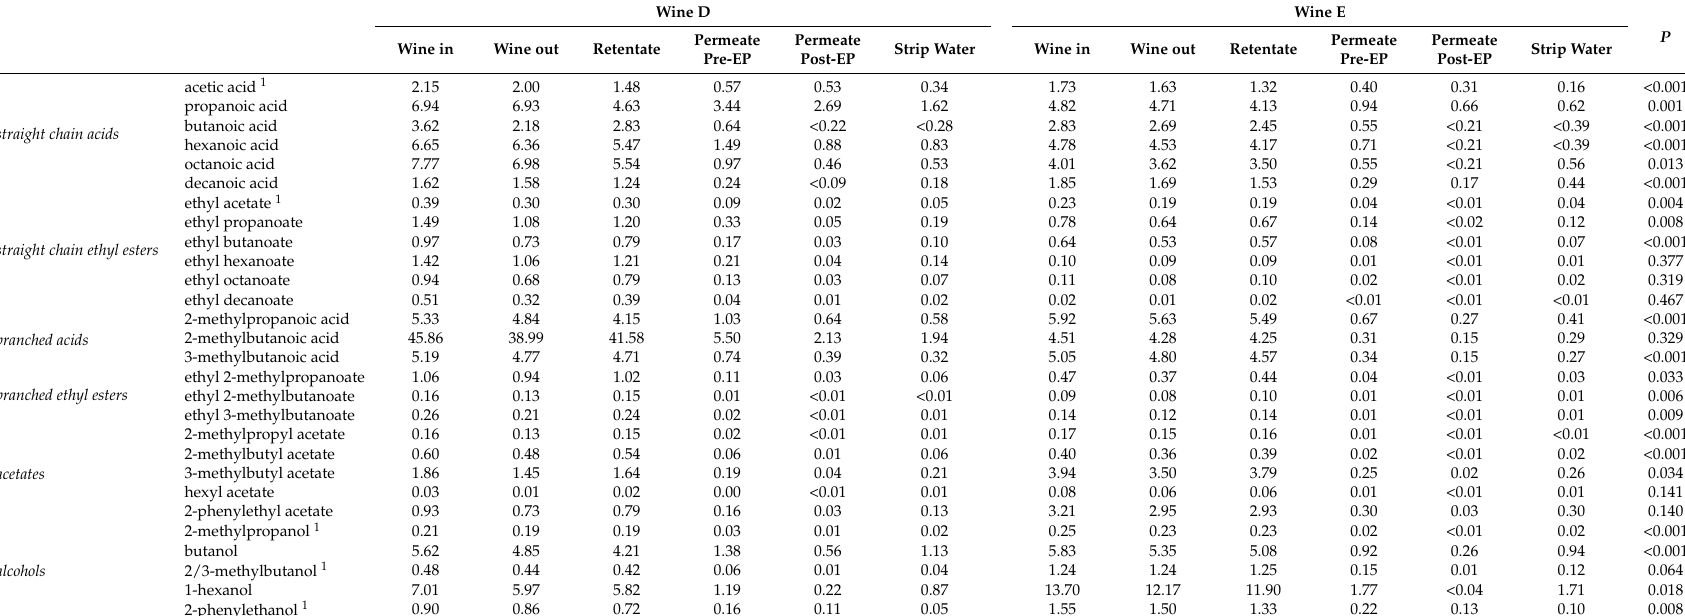
Table 5. Mass flow of fermentation volatiles present in samples collected during RO-EP treatment of Trial 2